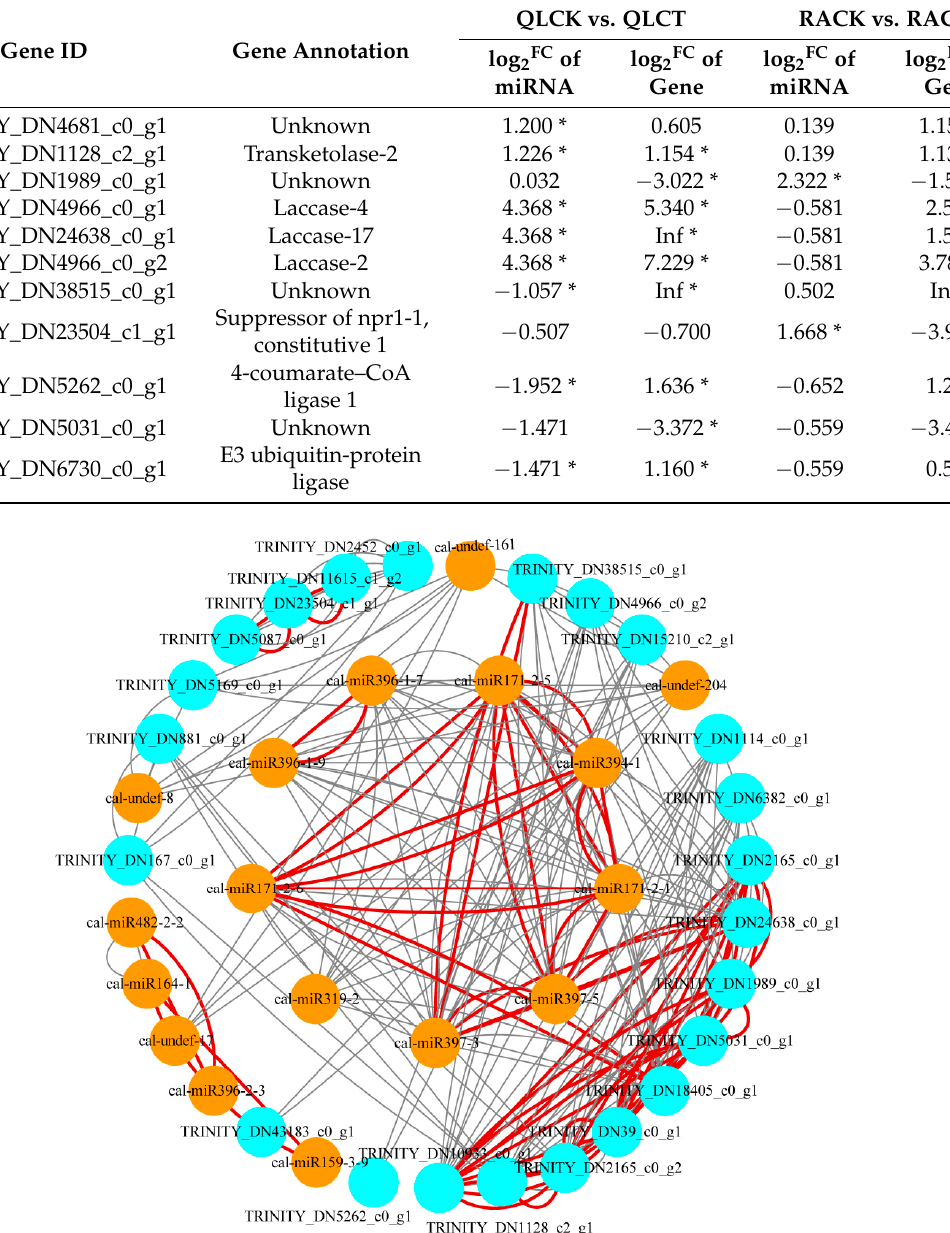
Figure 6. The miRNA–mRNA regulatory network in response to LTS in C. album . The orange circles represent miRNAs, and the blue circles represent the predicted target genes of DEMs. The red line indicates that the PCC value is more than 0.9, and the gray line indicates that the PCC value is more than 0.8.